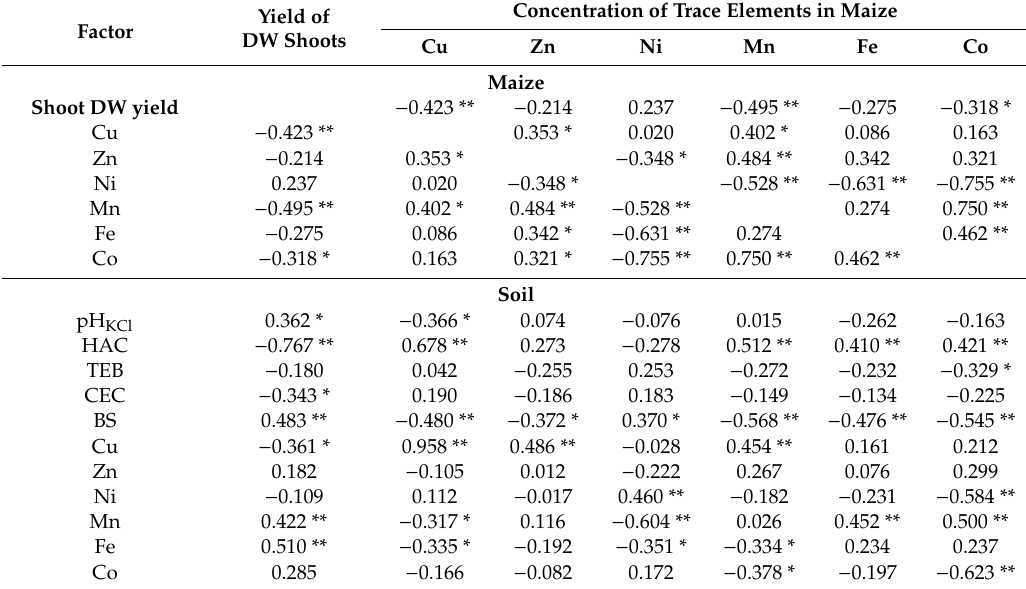
Figure 3. E ff ect of amendments on yield of DW shoots and concentration of trace elements in shoots of maize ( Zea mays L.), illustrated with the PCA method. Results of PCA performed with yield of DW shoots and concentration of trace elements in shoots of maize (WA—without amendments; C—compost; B—betonite; Z—zeolite; 1—0 mg; 2—50 mg; 3—100 mg; 4—150 mg; 5—200 mg Cu / kg of soil. Table 5. Correlation coe ffi cients (r) between yield of DW shoots, concentration of trace elements in shoots of maize ( Zea mays L.) and concentration of trace elements and some other properties of